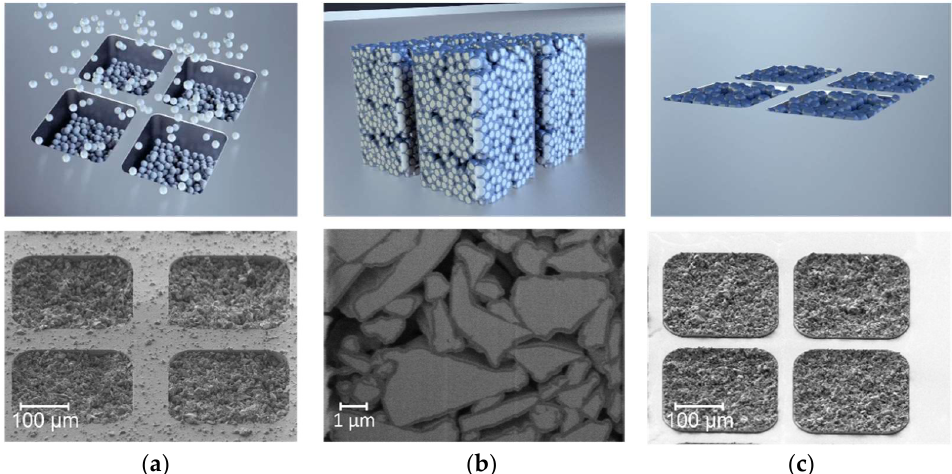
Figure 1. Illustration of the PowderMEMS process [19] by schematic drawings ( top ) and corre- sponding SEM micrographs of real samples, obtained from NdFeB powder ( bottom ): ( a ) Dry-filled micro-molds with particles. ( b ) Solidification of the powder bed via ALD. The blue layer in the drawing represents the ALD layer (not to scale). The surrounding substrate is not shown for clarity. In the SEM micrograph the particles (NdFeB) appear bright grey, while the surrounding ALD layer (75 nm Al 2 O 3 ) is dark grey. ( c ) Removal of excess particles from the substrate surface to enable post-processing in a cleanroom environment.